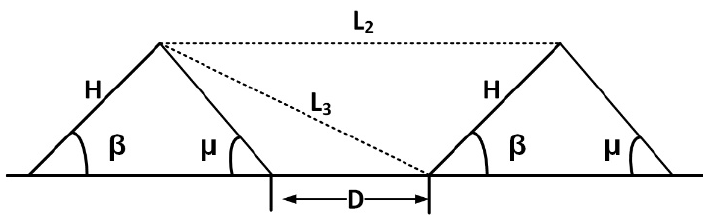
Figure 4. Multiple rows of collectors, 𝐻 , deployed on a horizontal plane.